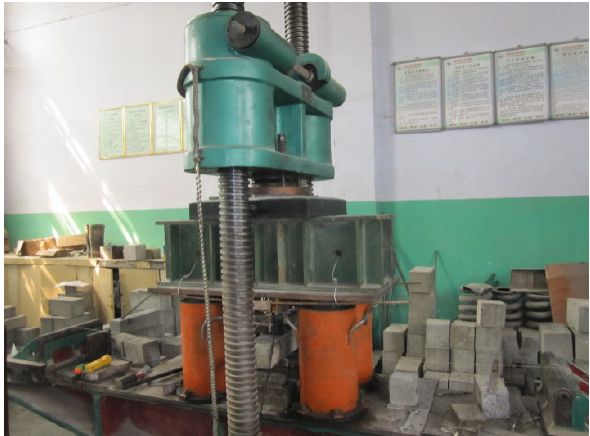
Figure 2: Testing apparatus of bending test